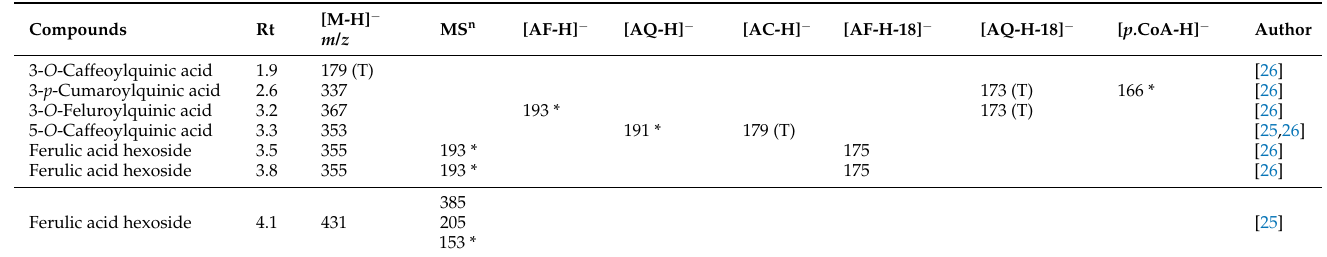
Table 3. Additional phenolic compounds present in BFPP, detected by LC-MS analysis in negative mode, and corroborated by previous reports in the literature.